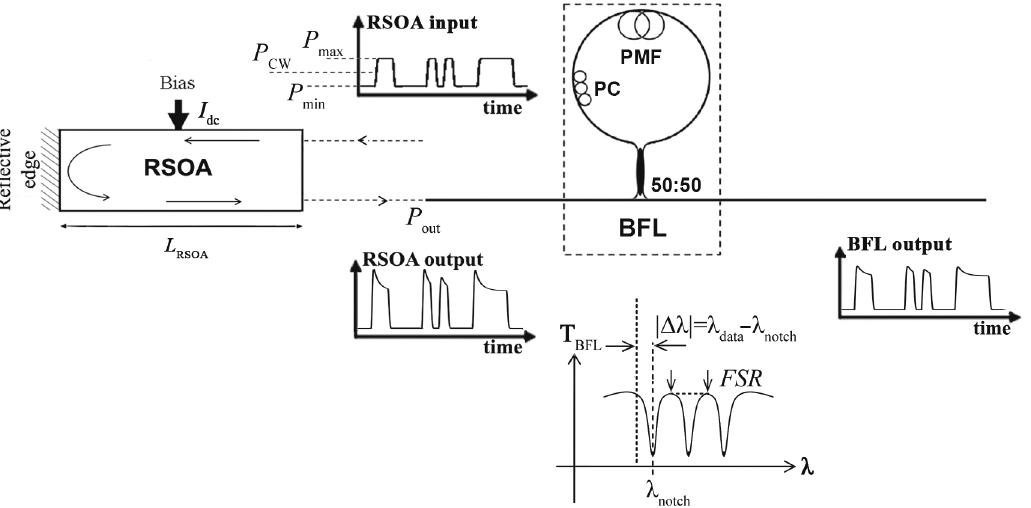
Figure 1. Block diagram of RSOA optically modulated by NRZ data and followed by BFL to overcome pattern-dependent distortion. FSR , ∆ λ : free spectral range and detuning, respectively, of the BFL response, T BFL